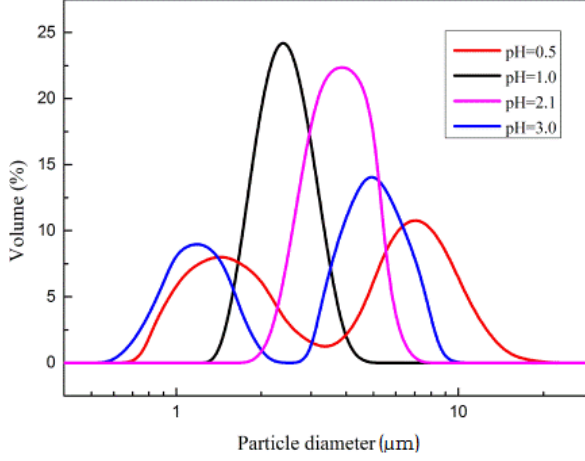
Figure 1: The SEM images of PSMs prepared at different silica sol addition, (A) 12g; (B) 14g; (C) 16g; (D) 18g